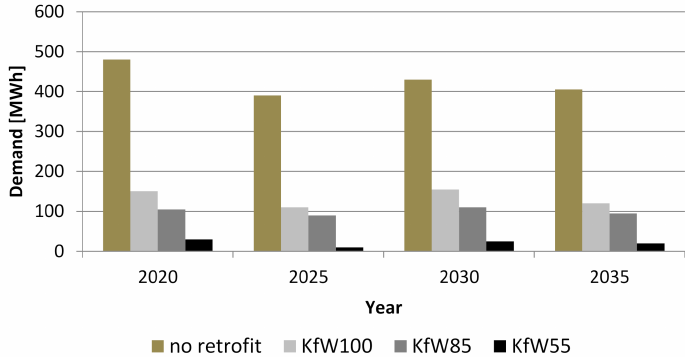
Figure 7. Annual heat demand for the regarded system, assuming the entire building stock has the same building standard.